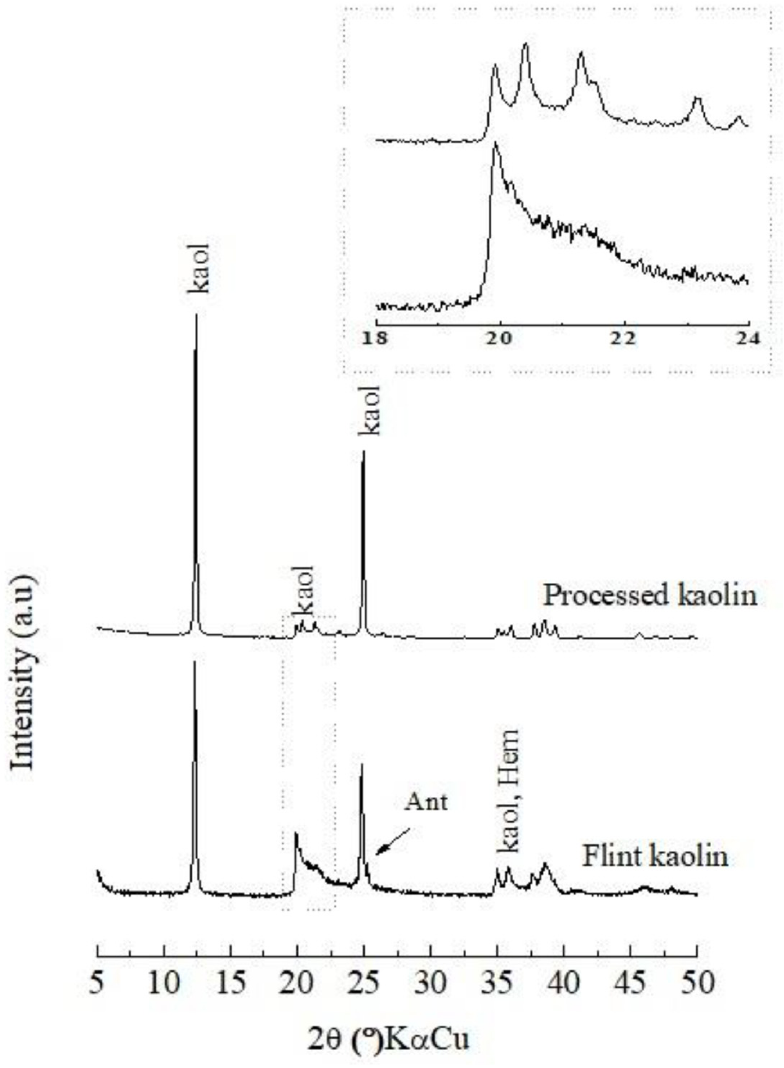
Figure 1. XRD flint kaolin and processed kaolin: kaol = kaolinite; Ant = anatase; Hem = hematite. Table 1. Chemical composition of the flint